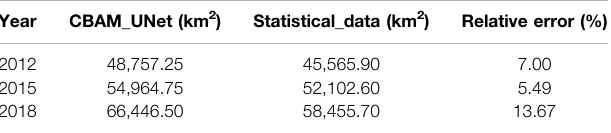
TABLE 5 | Comparison of extracted areas to statistical